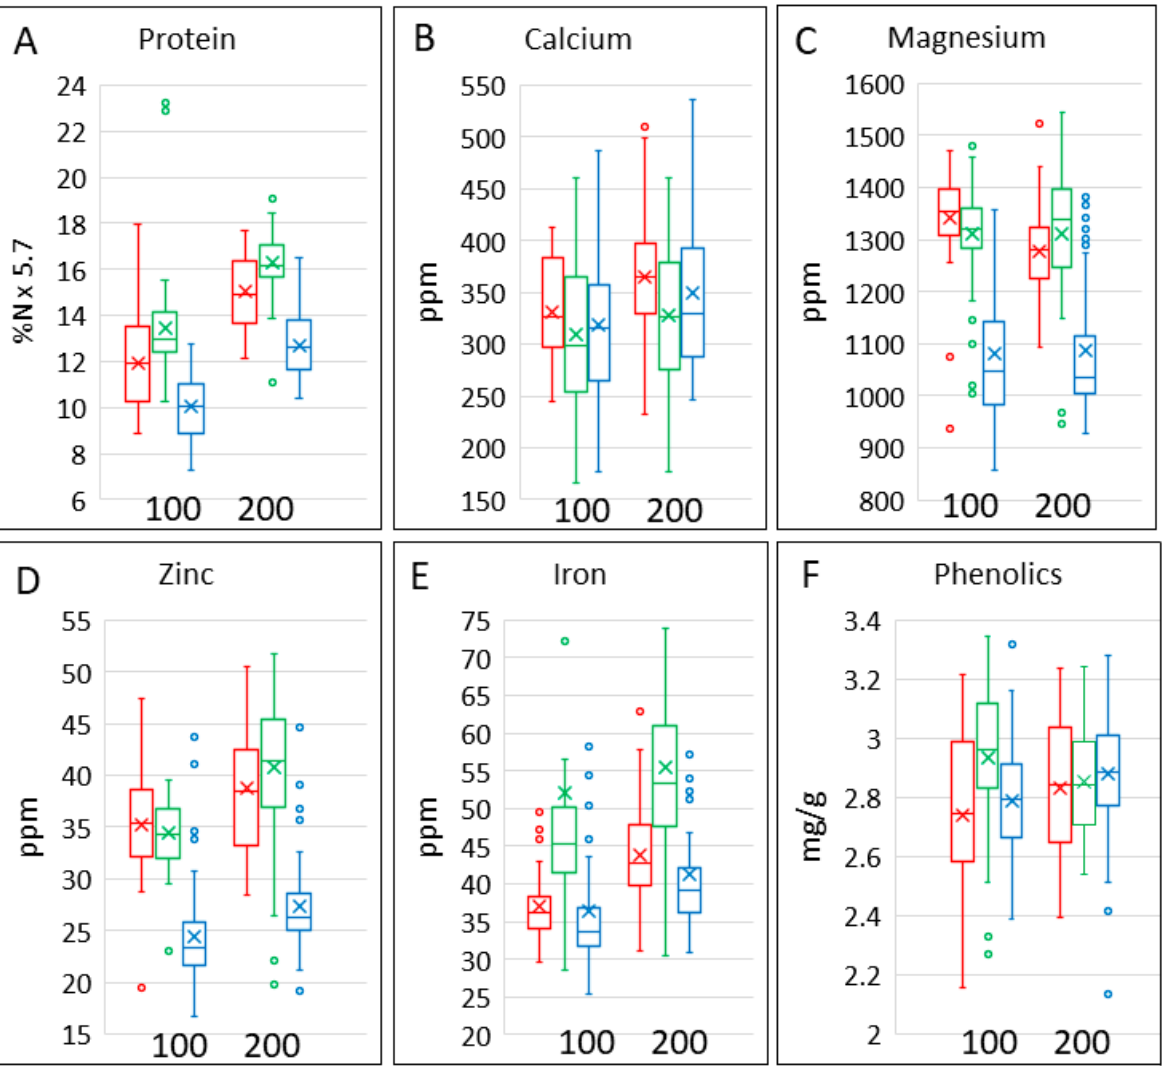
Figure 2. Contents of protein, minerals and total phenolics in grains of the three cereal types grown in four environments. Colour code: red, emmer; green, spelt; blue, bread wheat. The bar shows the range of the whole dataset. The box shows the middle two quartiles, separated by the horizontal line, which is the median, and the vertical lines are the upper and lower quartiles, respectively. Outliers are shown as circles. The x is the mean average. All analyses are expressed on a dry weight basis.